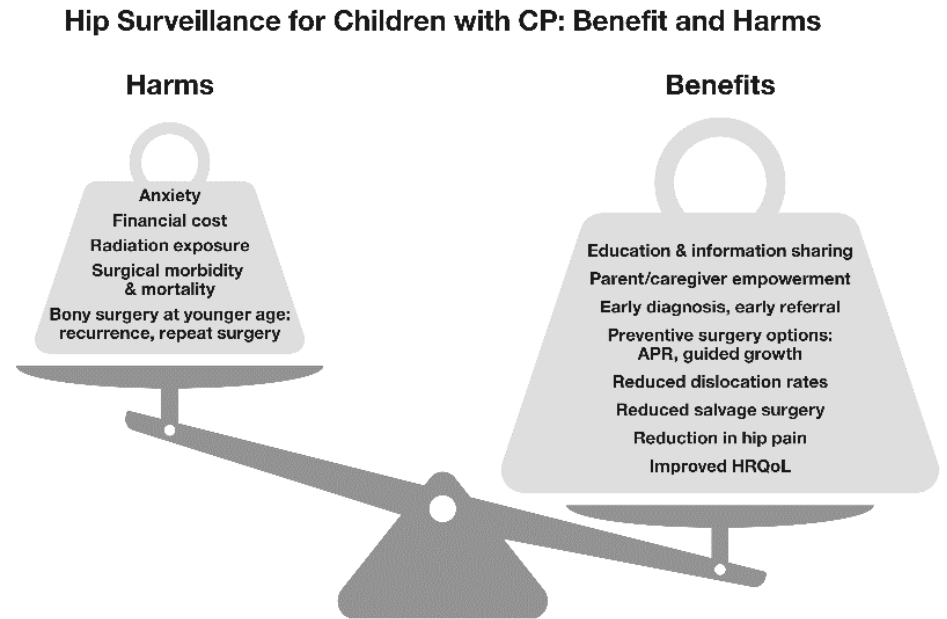
Figure 2. The benefits and harms of hip surveillance. Copyright Bill Reid, Kate Willoughby and Kerr Graham, RCH Melbourne. Some of the potential benefits and harms of hip surveillance are shown as a ‘see-saw’ or ‘teeter-totter’. Through hip surveillance, early identification of hip displacement and referral to orthopaedics provide options for surgical management. This, in turn, introduces additional potential harms and benefits. There is strong evidence that the benefits outweigh the harms for children with cerebral palsy as a population. The benefit to harm experience however is not just for study cohorts or populations, but is experienced by individual children and their families. While early bony surgery is safe and effective in the short term, the associated harm is a high recurrence and surgery revision rate. This could be reduced, perhaps, through ‘temporising’ surgical options such as adductor-psoas muscle release (APR) and/or guided growth. As noted elsewhere, surgery is safer and more successful when conducted in the context of an experienced, multidisciplinary team which includes high volume, experienced surgeons.